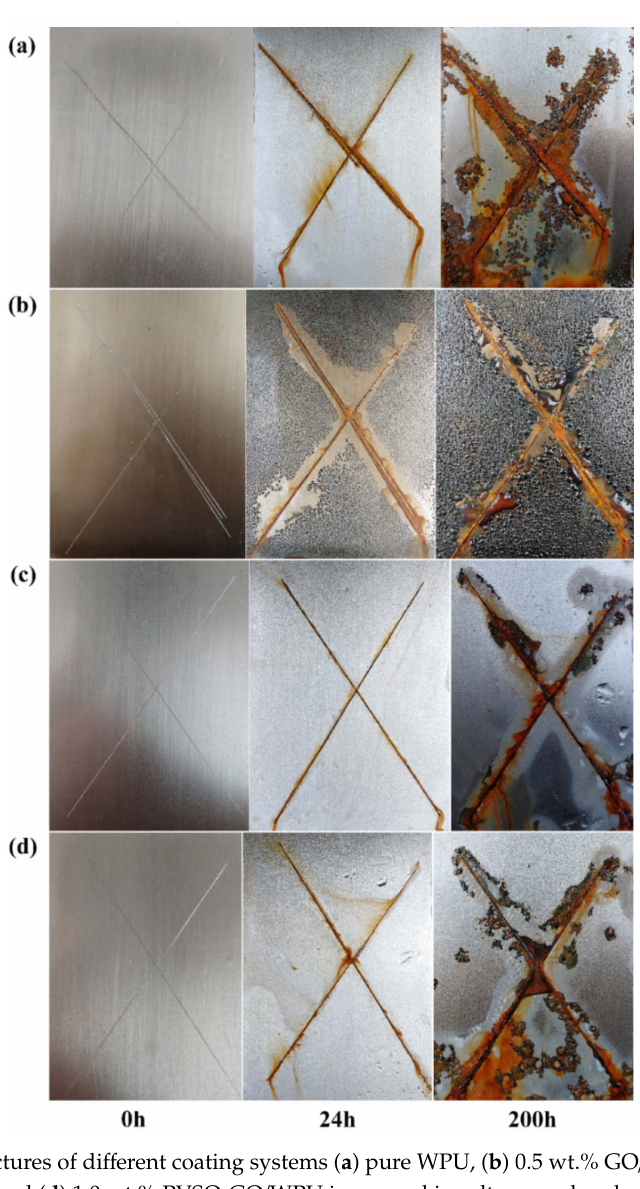
Figure 14. The pictures of di ff erent coating systems ( a ) pure WPU, ( b ) 0.5 wt.% GO / WPU, ( c ) 0.5 wt.% PVSQ-GO / WPU, and ( d ) 1.0 wt.% PVSQ-GO / WPU immersed in salt spray chamber after 200 h.